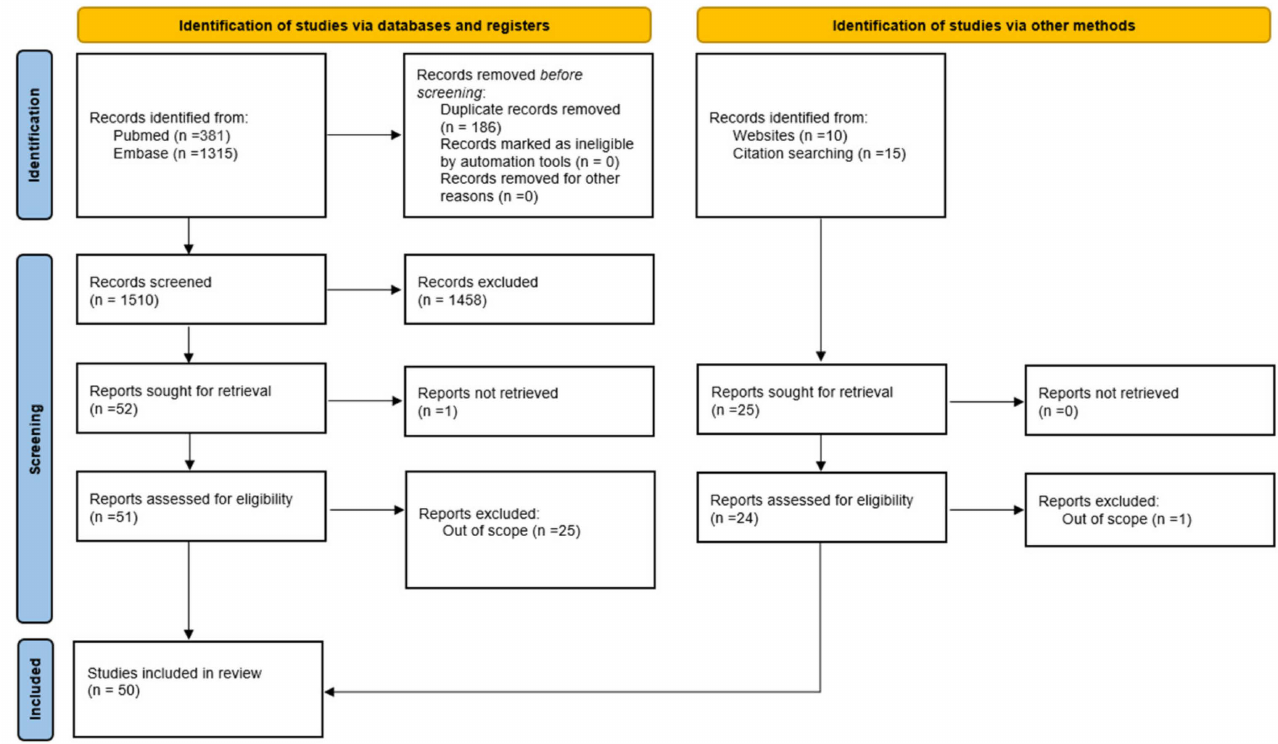
Figure 1. Study selection